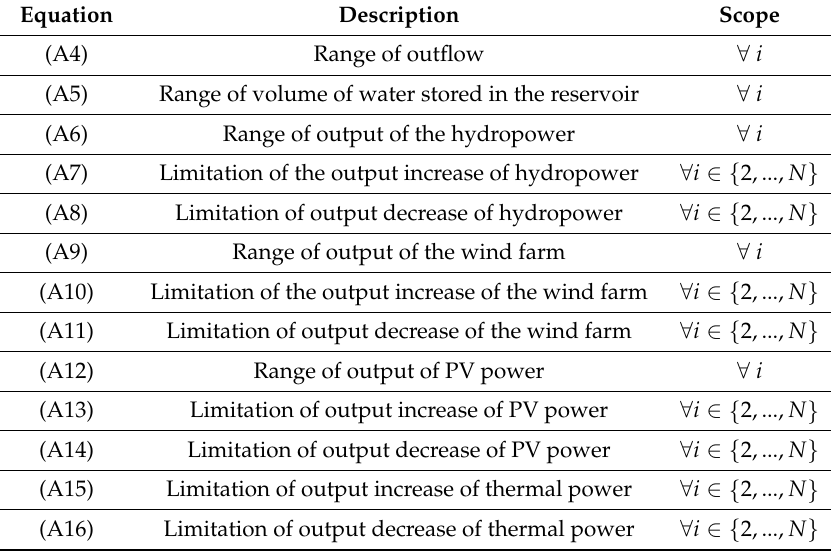
Table A5. Constraints of the power station.